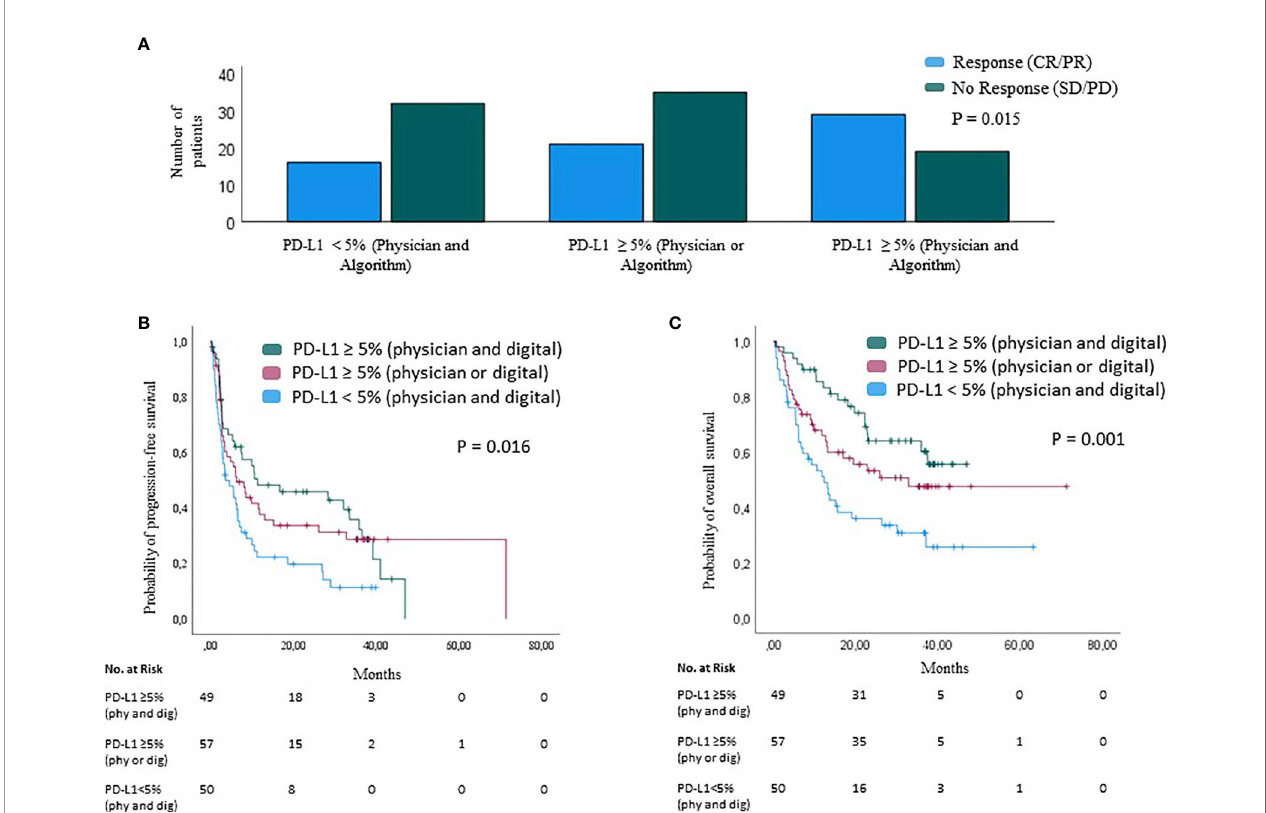
FIGURE 5 | Therapy response and survival analysis based on PD-L1 expression analysis by physician and digital algorithm. Best overall response, BOR (A) and survival (B, C) of n=156 melanoma patients upon PD-1-based immune checkpoint inhibition by tumor PD-L1 expression. Tumor PD-L1 expression is presented as a combination of physician and digital quanti fi cation. (A) BOR is highest in patients with tumor PD-L1 positivity by both physician and digital quanti fi cation (CR/ PR=60.4%; right), compared to patients with tumor PD-L1 positivity by only one of both quanti fi cation methods (CR/PR=37.5%; center), and patients whose tumors are classi fi ed as PD-L1 negative by both physician and digital quanti fi cation (CR/PR=33.4%; left); Chi-square test P = 0.015. (B, C) Progression-free (B) and overall survival (C) by tumor PD-L1 expression combined of physician and digital quanti fi cation. P values were calculated using the log-rank